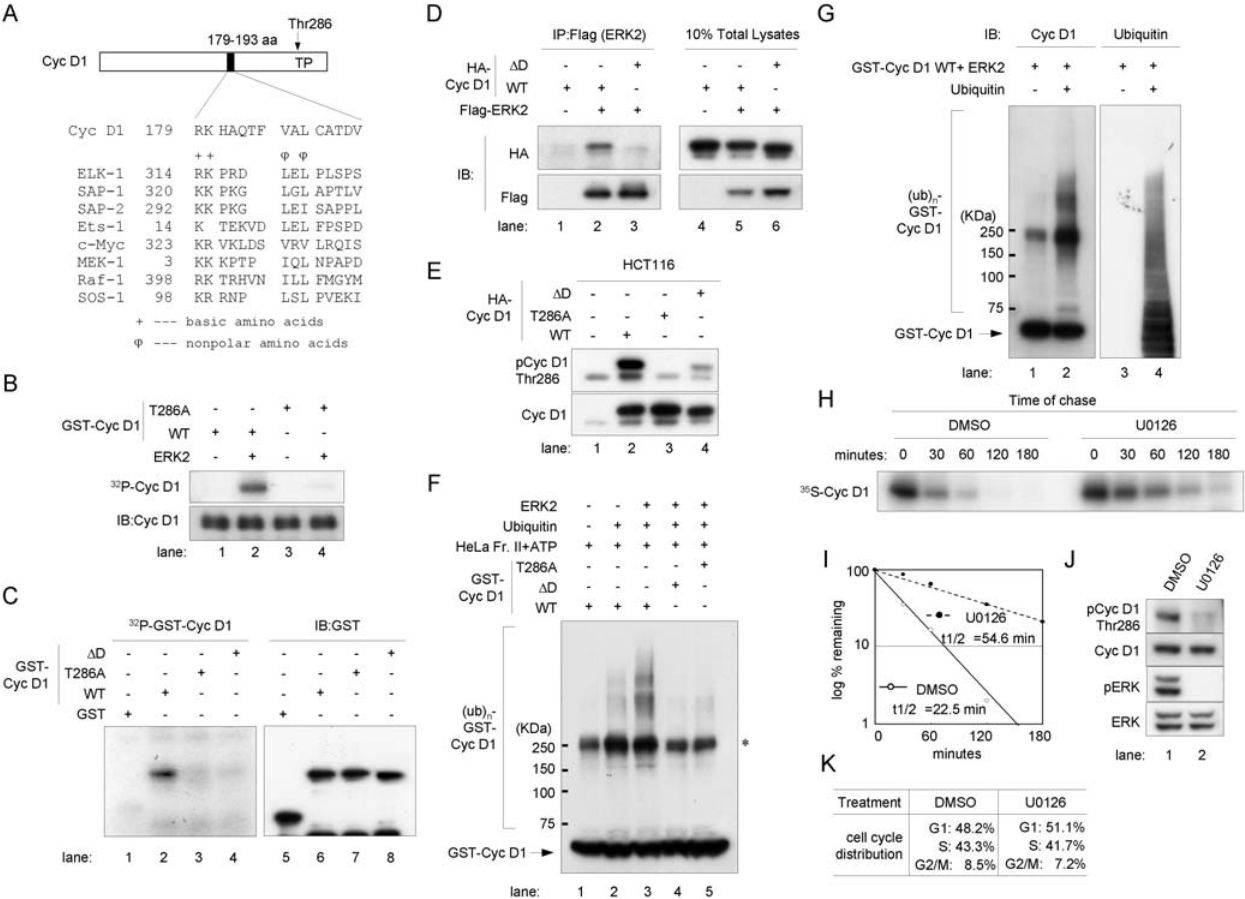
Figure 2. MAPK phosphorylates cyclin D1 at Thr286, which triggers subsequent ubiquitination. (A) Identification of the D-domain in cyclin D1 (Cyc D1). The illustration of full-length human Cyc D1 shows the region of the D-domain (A.A. 179-193) and the MAPK phosphorylation site Thr (T) 286 followed by proline (P) (solid bar and an arrow, respectively). The amino acid sequence of the D- domain within Cyc D1 is aligned with other known MAPK-docking sites of various ERK substrates. The doublet of basic ( + ) and nonpolar ( Q ) amino acids are conserved residues in the core D-domain motif L/I/V-X-L/I/V. Amino acid positions of the most 5 9 residues of the D-domains are indicated with numbers in the left of each amino acid sequence respectively. (B, C) p42 ERK2 in vitro kinase assays for cyclin D1 (upper panels). (B) Wild type or T286A mutant recombinant GST- full length Cyc D1 protein was mixed with 32 P-ATP in the kinase assay reaction buffer in the presence or absence of purified ERK2. Reactions were performed at 30 u C for 30 min and stopped by adding sample loading buffer. Samples were separated with SDS-PAGE and 32 P-uptake was detected by autoradiography. Immunoblotting (IB) analysis using antibodies to cyclin D1 is provided as a reference to show substrate amounts. (C) GST alone (lane 1), GST-C-terminal WT Cyc D1 fusion protein retaining the binding site of MAPK (amino acids 165-295, lane 2), T286A (lane 3) and a complete deletion of the D-domain D D, lane 4) were used. IB analysis using antibodies to GSTs provided as a reference to show substrate amounts. (D) Immunoprecipitation (IP) and IB analysis following ectopic expression of Flag-tagged ERK2 together with either HA-tagged WT or D D Cyc D1 in HCT 116 colon cancer cells. A Western blot for input controls (10% total lysates) is also shown. (E) Western blot analysis with Thr286 phosphorylated cyclin D1 (pCycD1 Thr286) and total Cyc D1 following transfection of various forms of